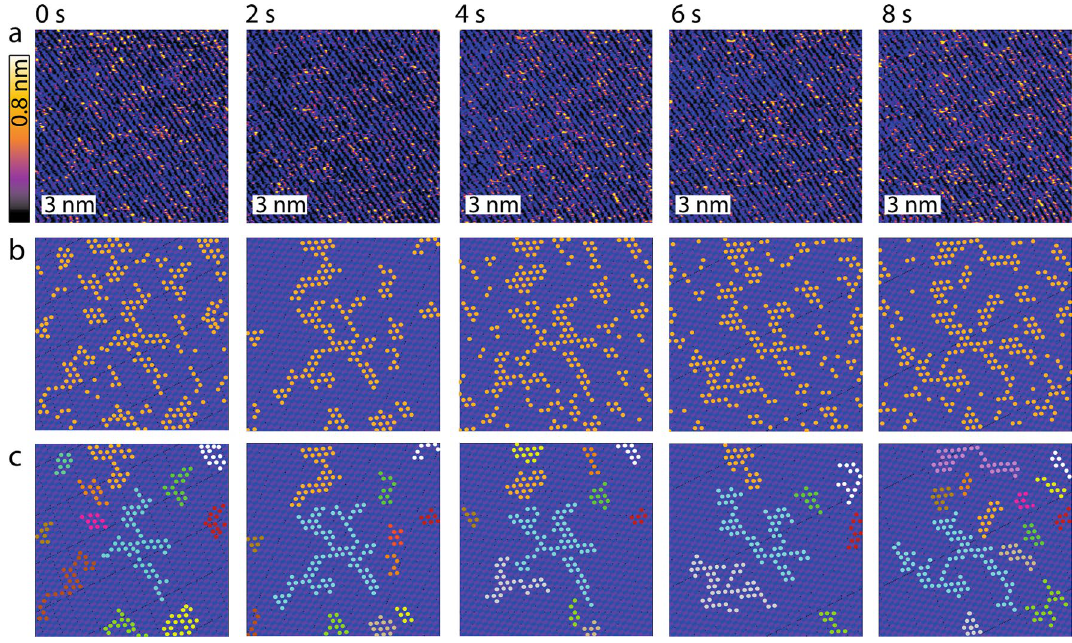
Figure 1. Example of time evolution for adsorbed Rb + ions at the mica-water interface in the presence of a shear flow. ( a ) A time-lapse sequence shows consecutive high-resolution HS-AFM topographical images of Rb + ions at the interface between mica and a 5 mM RbCl aqueous solution. Rb + ions appear as bright orange- yellow protrusions standing taller than the mica surface (purple-black). Periodic rows and larger domains are clearly visible as well as singly adsorbed rubidium ions. ( b ) Representative image analysis highlighting Rb + ions as orange markers (obtained by thresholding) and the idealised underlying lattice derived by inverse Fourier transform of the filtered power spectrum in each image of ( a ) (see ESI Section 3 for details on the procedure). ( c ) The algorithm automatically associates neighbouring ions (within distances < 0.52 nm) to the same cluster. Domains smaller than 5 ions are discarded here. The different clusters derived in each image are highlighted using different colours, keeping for each cluster the same colour over time. The cyan-coloured cluster offers a good example of temporal evolution. The scale bars in ( a – c ) represent 3 nm and the z-scale in ( a ) corresponds to 0.8